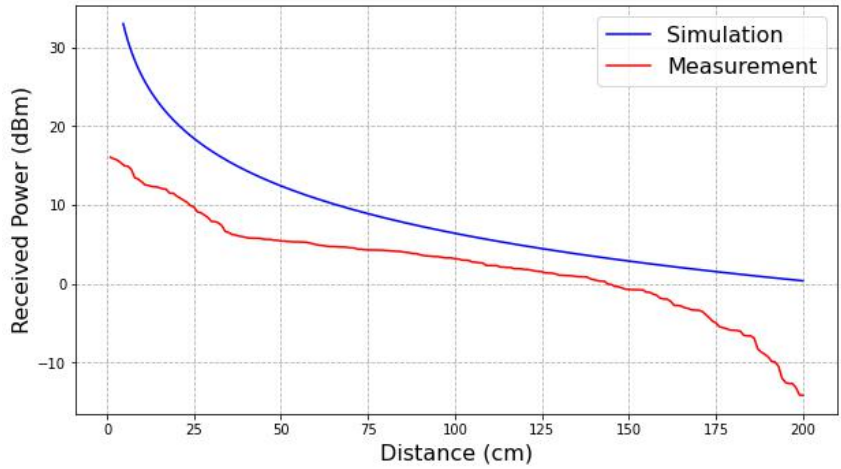
Figure 7. Simulated and measured RF scavenging power using transmission distance–collinear an- tenna.